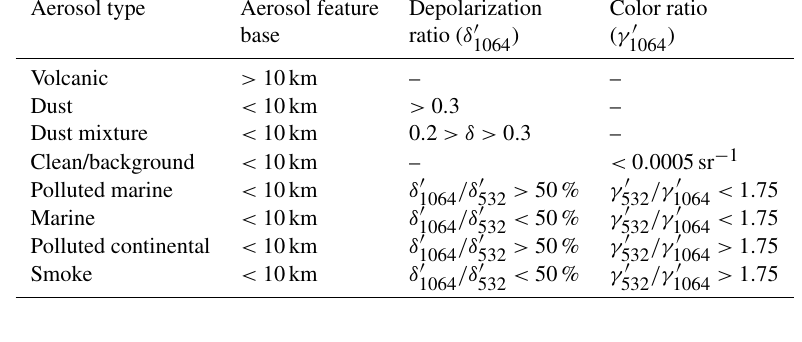
Table 1. Classification of aerosol types for CATS operating mode 7.1 (Yorks et al., 2016).